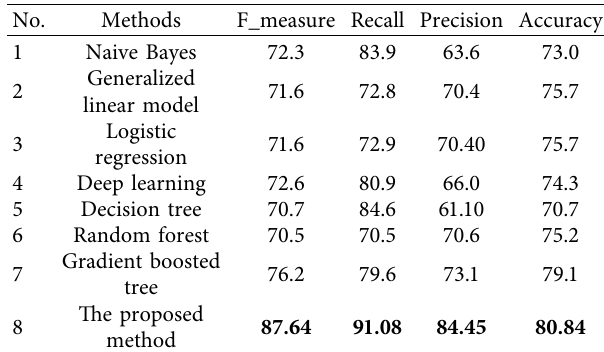
Table 3: Comparing the performance of the proposed system and other methods in different evaluation